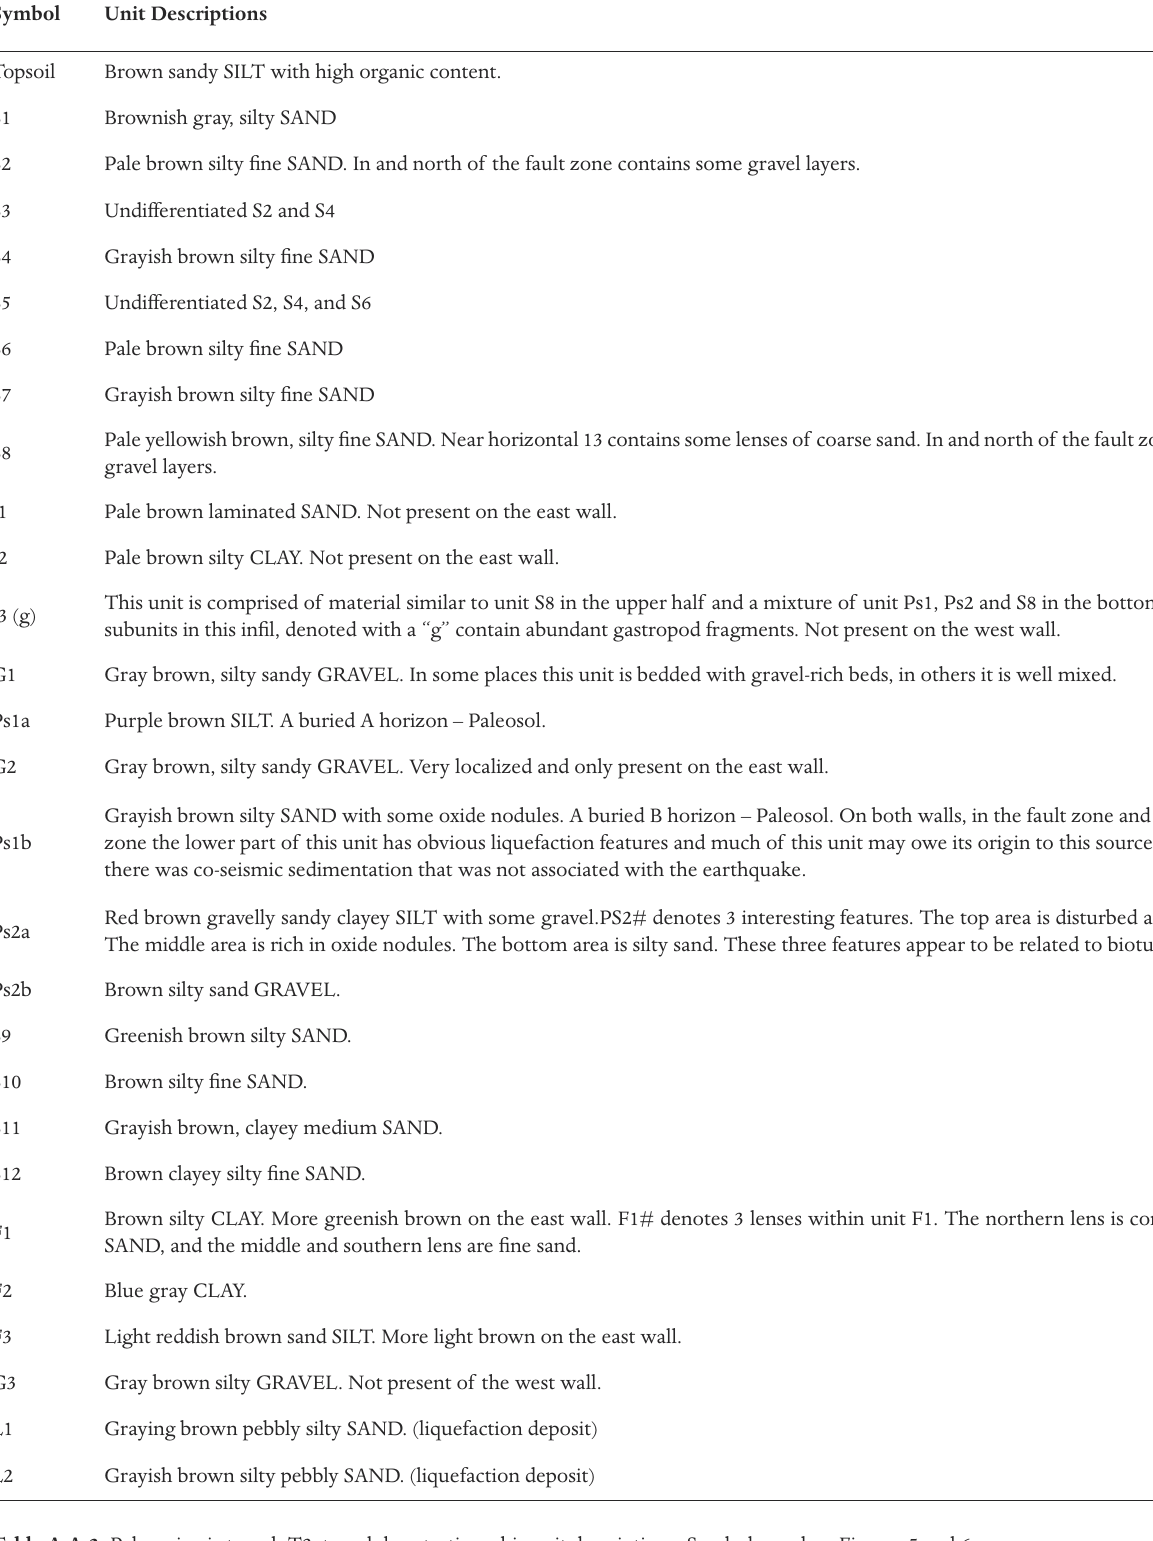
Table A.A-2. Paleoseismic trench T2: trench log stratigraphic unit descriptions. Symbols used on Figures 5 and